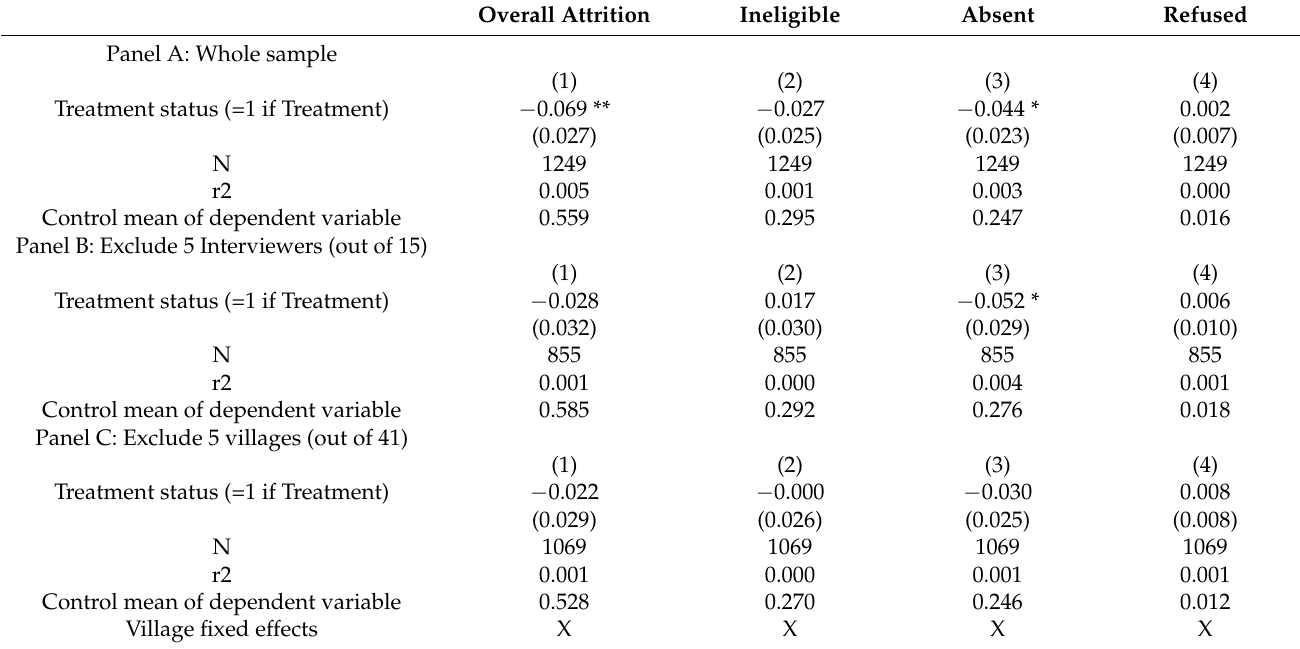
Table 1. Attrition at baseline